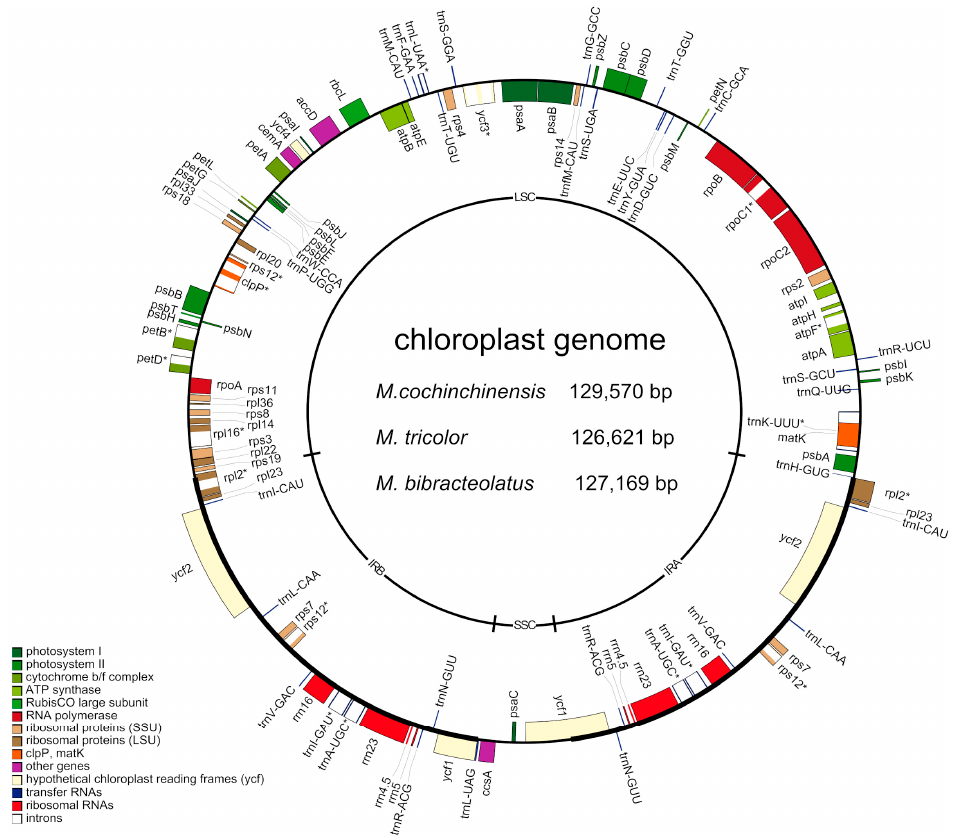
Figure 2. Gene map of the complete chloroplast genome of three Macrosolen species. Genes outside the large ring circle are transcribed in a counter-clockwise direction, and genes inside the circle are transcribed clockwise. The same color represents the same category of genes. Deep grey in the inner circle represents GC content, and lighter grey represents A / T content. Table 2. Gene list of chloroplast genome of three Macrosolen species.